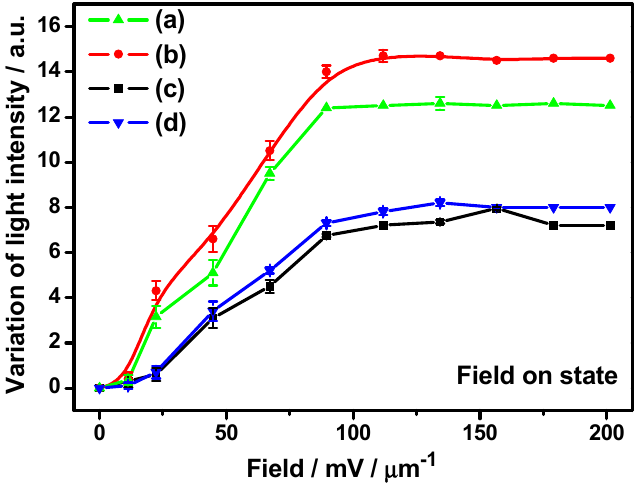
Figure 2. The measured reorientation-induced light intensity variation of representative GP flakes according to Figure 1. The applied electric fields for Case I and Case II are 0, 22, 44, 67, 90, 100, 112, 134, 156, 180, and 200 mV/µm, respectively (Case I: flake area and aspect ratio in ( a , b ): 35 µm 2 with an aspect ratio of 2:1 and 85 µm 2 with an aspect ratio of 1:1; Case II: flake area and aspect ratio in ( c , d ): 37 µm 2 with an aspect ratio of 2:1 and 90 µm 2 with an aspect ratio of 1:1). The scattered points represent experimental data along with measurement error bars and the lines are guides for the eye. Error bars for respective data points are assigned considering standard deviations obtained in the repetitive observations.